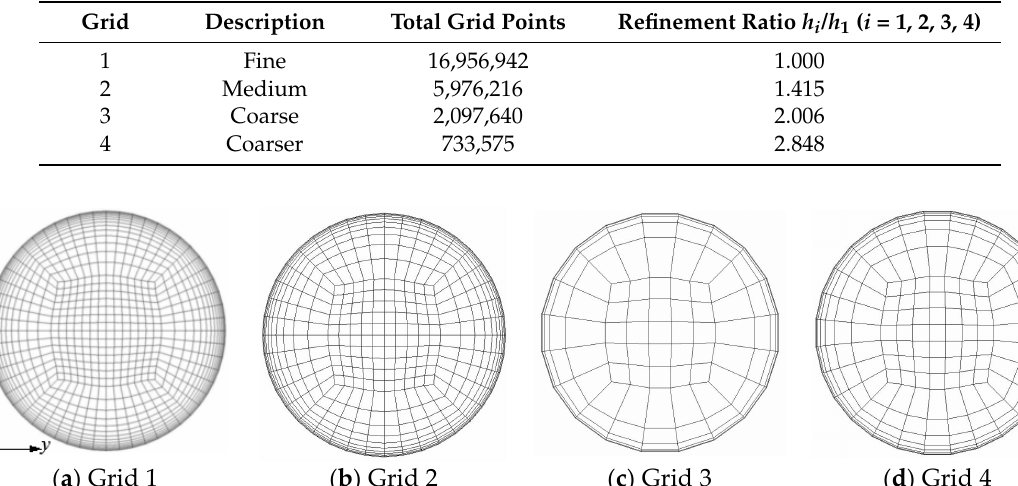
Table 2. Dimensions of the grid series.